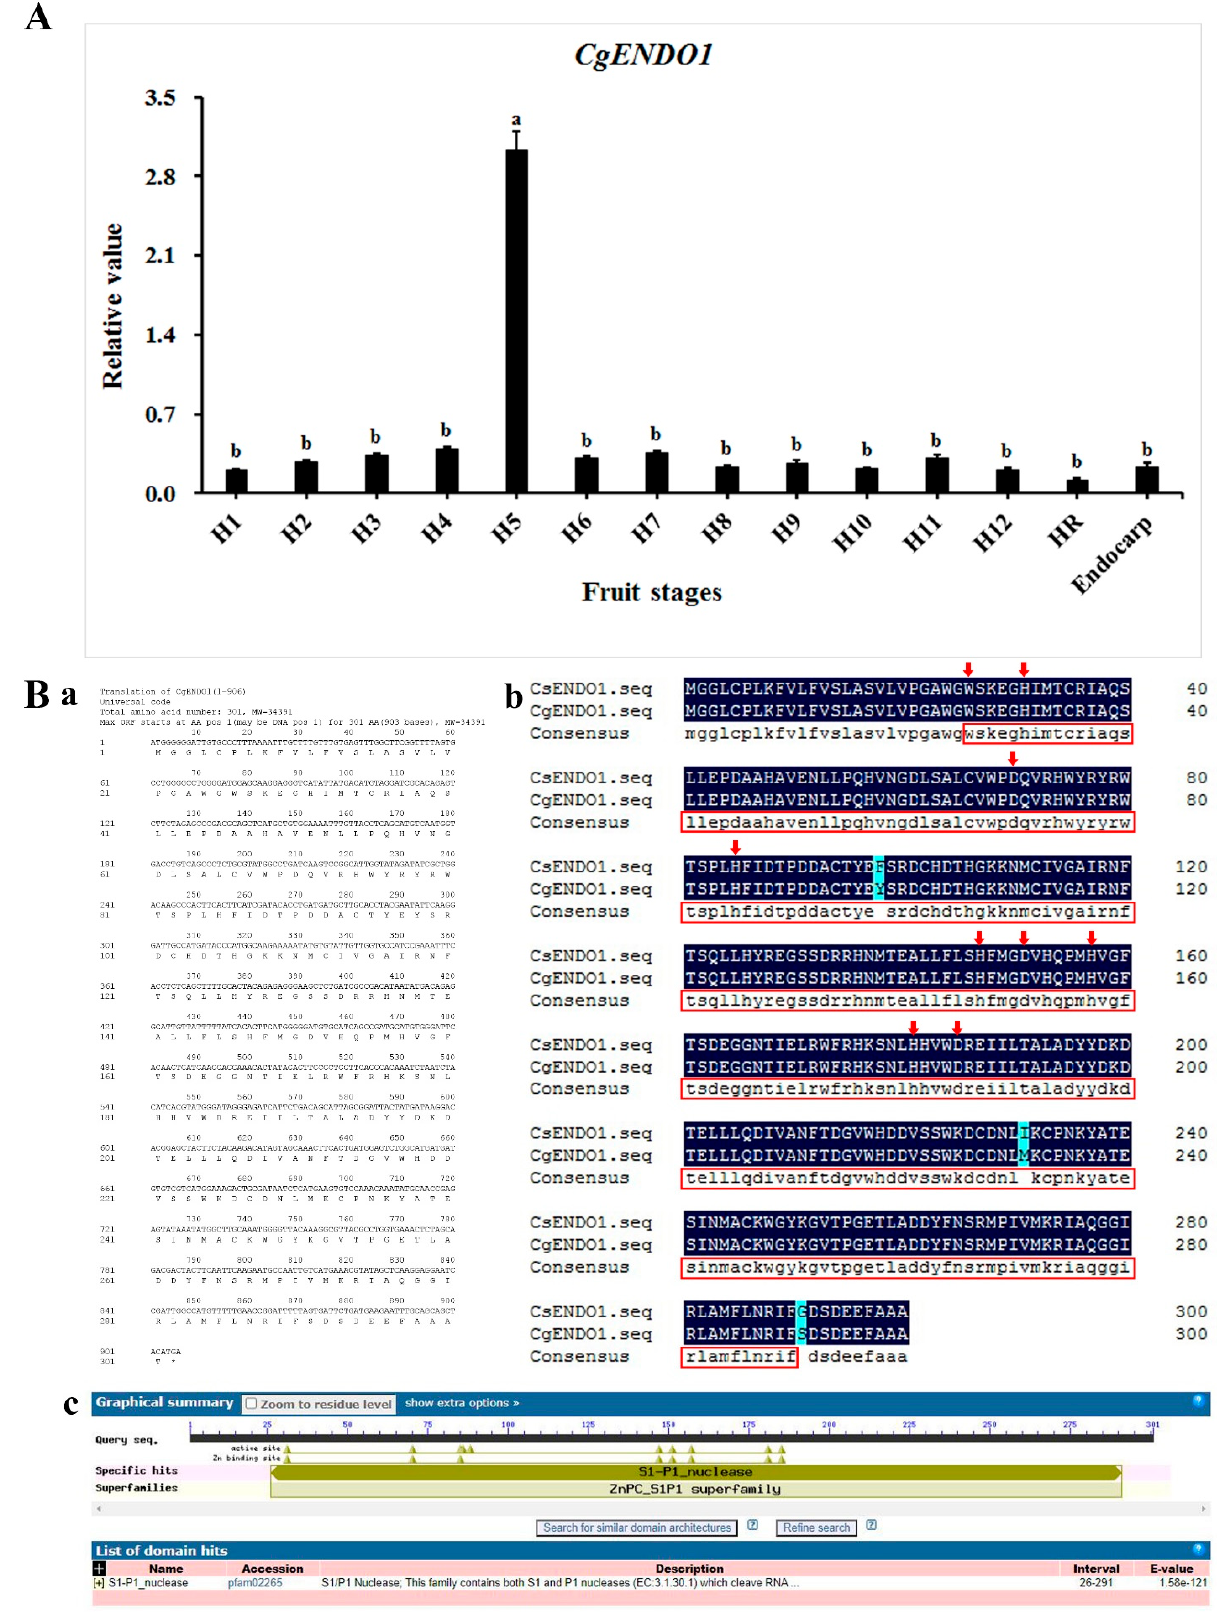
Figure 1. Gene expression and sequence analysis of CgENDO1 . ( A ) Expression analysis of CgENDO1 involved in the PCD process of the secretory cavity of Citrus grandis ‘Tomentosa’ fruits. CgENDO1 was expressed in each grade of fruit, and the highest expression was found in sample H5 (the sampling statistics showed that H5 was mainly in the late initial cell stage and the lumen ‐ forming stage) (Figure S1). The exocarp of mature fruits and endocarp without a secretory cavity were both expressed at low levels. Different lowercase letters indicate significant differences at p ≤ 0.05 (Duncan’s multiple comparison). HR: Ripe fruit. ( B ) Sequence analysis of CgENDO1 involved in the PCD process of the secretory cavity of Citrus grandis ‘Tomentosa’ fruits. ( a ) The cDNA sequence of CgENDO1 and the amino acid sequence of CgENDO1. The 906 bp cDNA sequence was translated into a protein sequence in the DNAMAN8.0 software. ( b ) The protein sequence of